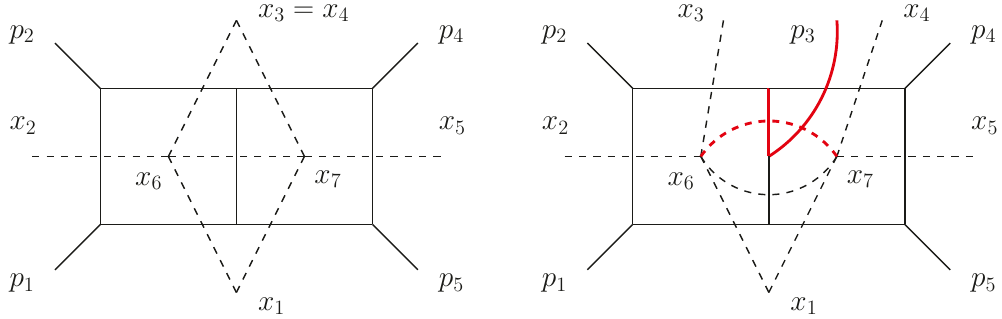
Figure 1 . Dual space for a planar graph and its nonplanar analog obtained by adding one